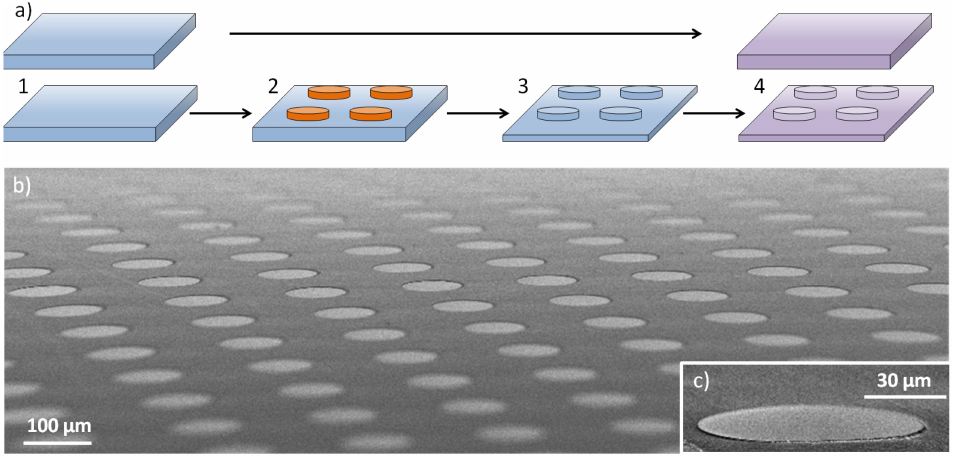
Figure 1. Substrate preparation: ( a ) fabrication schemes and ( b , c ) results. ( a substrate is coated with a positive photoresist (PPR) mask by photolithography, then ( a etched and the PPR is stripped before ( a ( b ) Scanning electron microscope (SEM) side view image of a pedestal array and ( c ) zoom onto one circular pedestal with a diameter of 100 μm